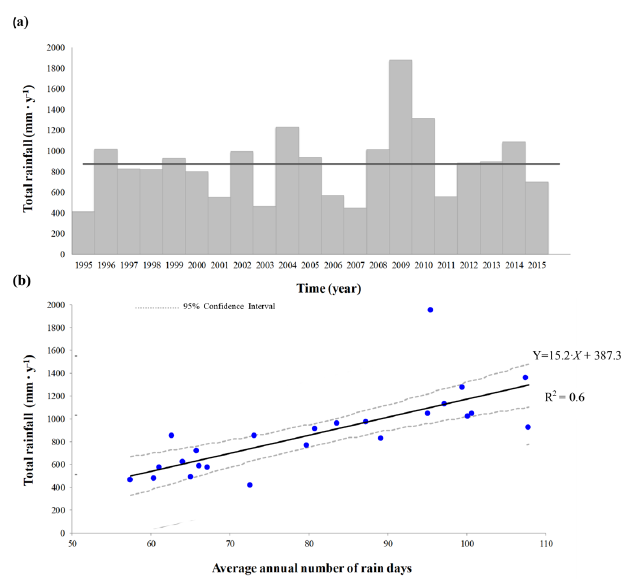
Figure 3. Precipitation in the grape-wine growing area PDO ‘Orvieto’. ( a ) Total precipitation per year and the climatic average (continuous line); and ( b ) linear relationship between total precipitation per year and annual number of rainy days (rain > 1mm/day). Data refer to the period between 1995 and 2015.